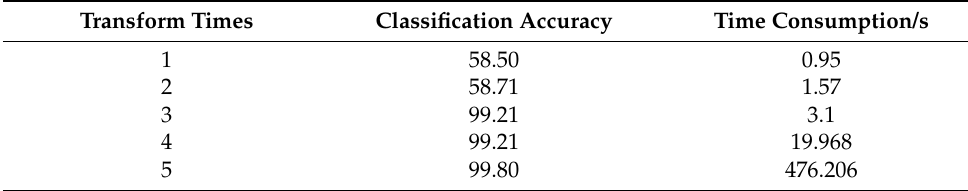
Table 3. Relationship between transform times and classification